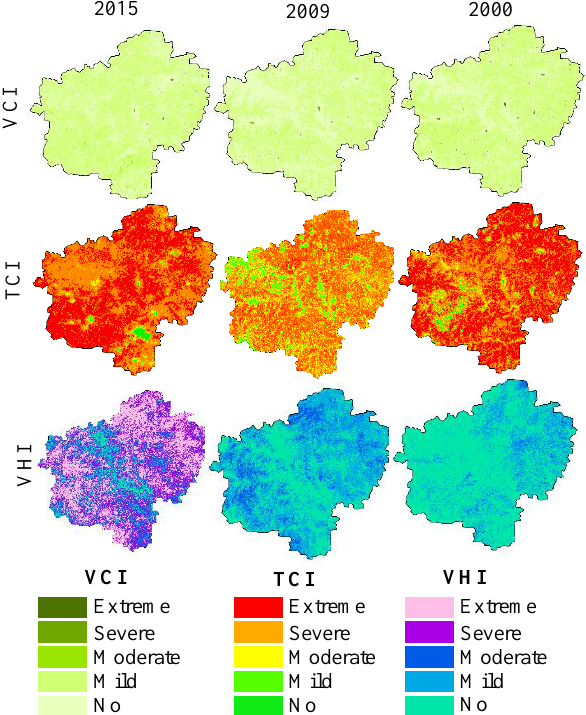
Figure 3: Spatial variation of drought due to soil moisture, thermal stresses and Vegetation health for April (Legends as per Table 1)